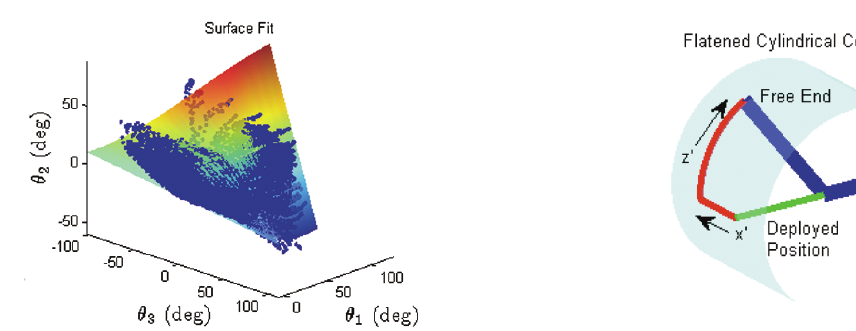
Fig. 11. Points lie very near a two dimension manifold, showing that only two independent degrees of freedom are expressed in deployment.